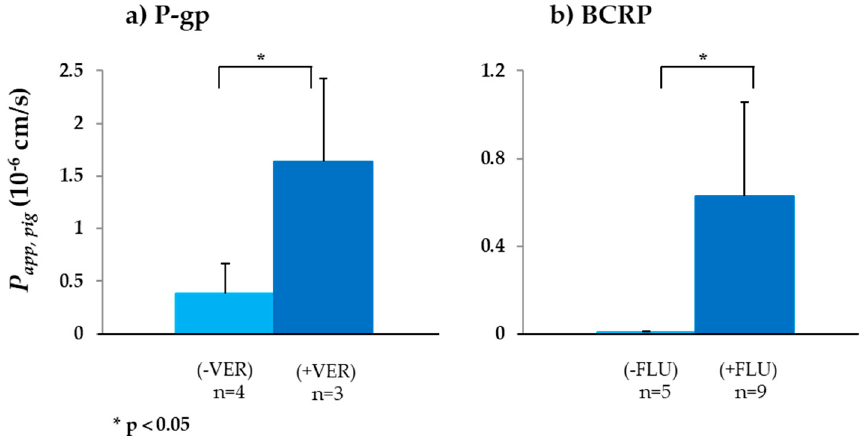
Figure 2. P app,pig values of ABC transport protein substrates: ( a ) P app,pig of the P-gp substrate digoxin in the absence ( − VER) and presence ( + VER) of the P-gp inhibitor verapamil (VER); ( b ) P app,pig of the BCRP substrate sulfasalazine in the absence ( − FLU) and presence ( + FLU) of the BCRP inhibitor fluvastatin (FLU) (mean ± SD; n = number of replicates).